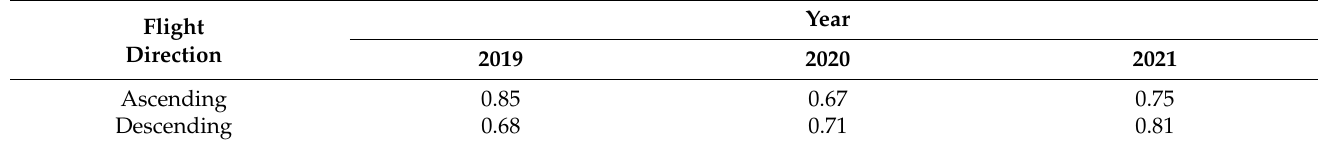
Table 3. Average residual phases of different flight directions from 2019 to 2021 (in rad).